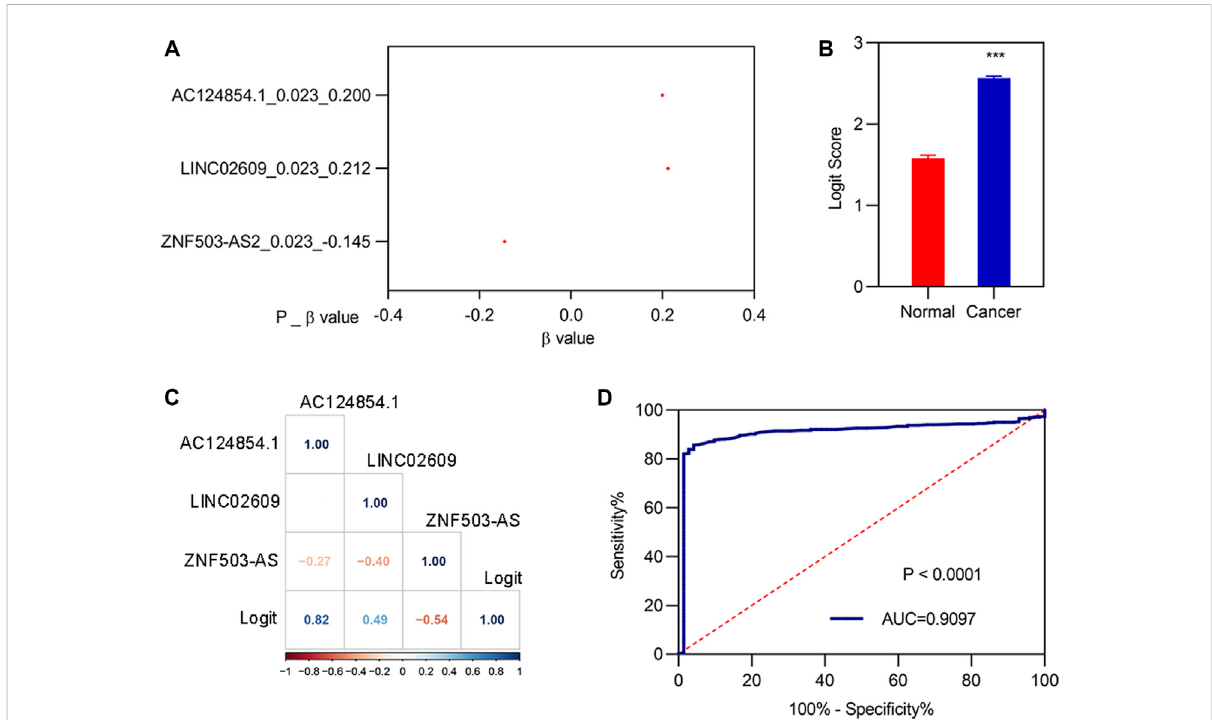
FIGURE 5 Construction of the diagnostic model. (A) β -value of the analysis of three FI-DELs by stepwise logistic regression. (B) Diagnosis values between normal and patients with KIRC. (C) Correlation analysis of the three FI-DELs with diagnosis values. (D) ROC curves of the diagnostic model. *** p < 0.001.